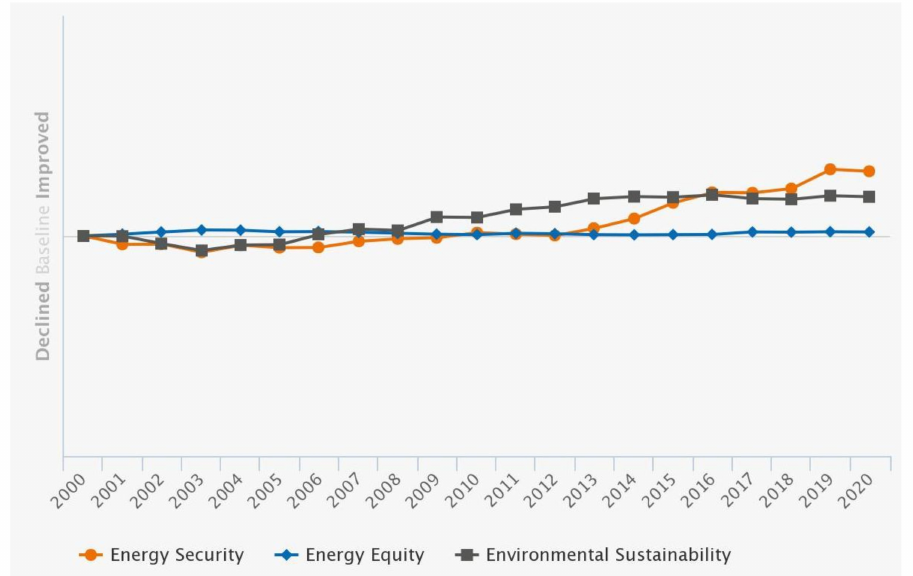
Figure 11. Trends of the components of the Energy Trilemma Index for Ireland, 2000–2020 (based on